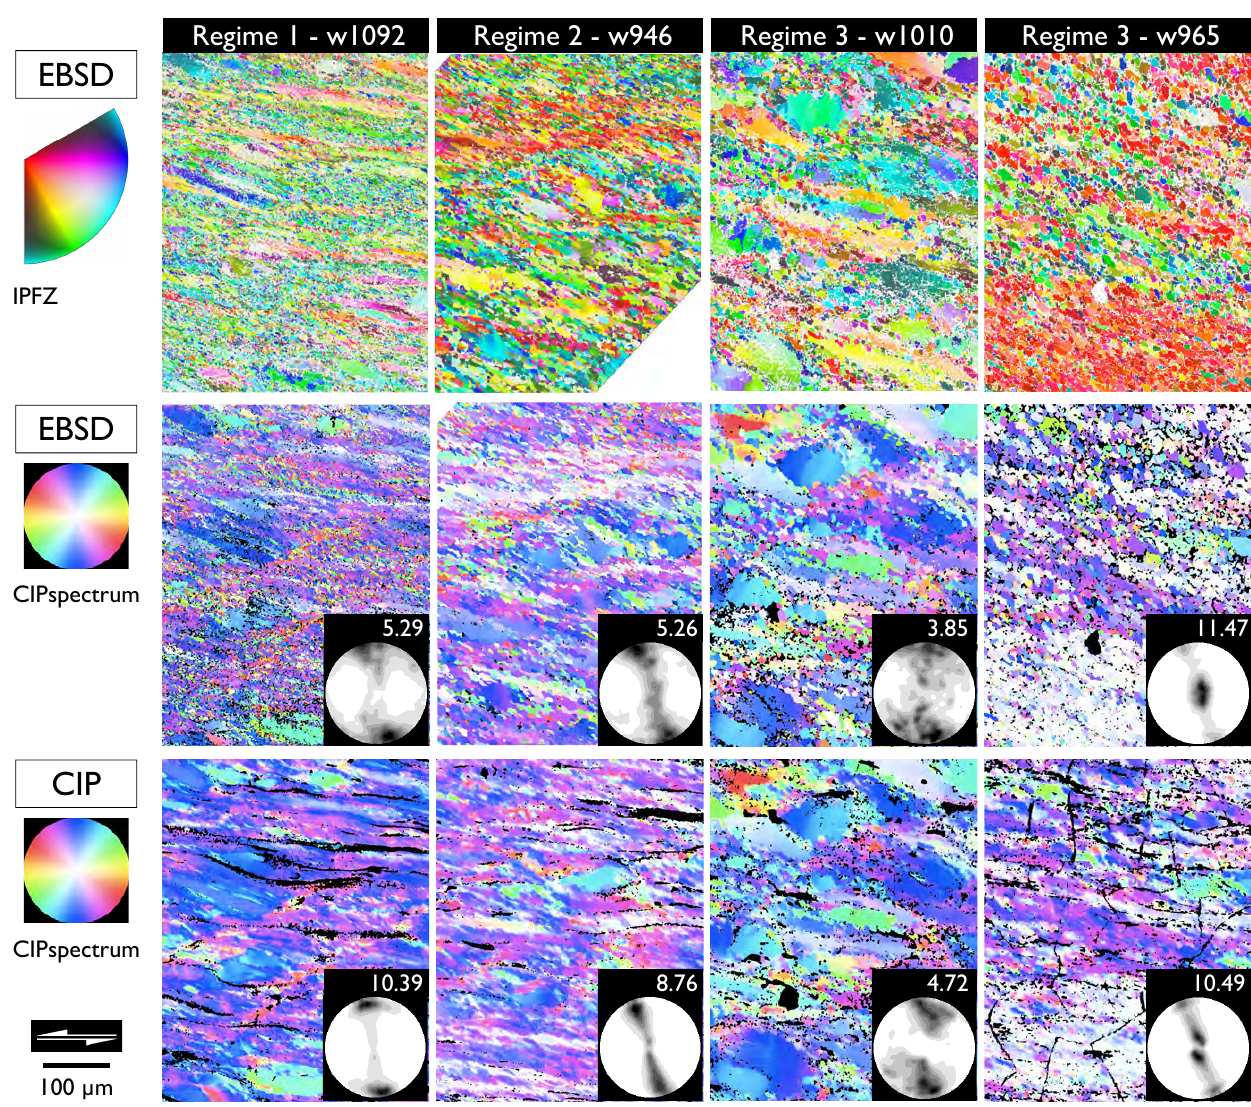
Figure 2. Orientation images. Details of four orientation images are shown with pole figures calculated from total maps. Top row: EBSD maps obtained from SEM using IPFZ (inverse pole figure coloring) for the z direction (image normal). Middle row: Same maps as in row above using CIPspectrum, i.e., LUT for c -axis orientation; c -axis pole figures calculated from EBSD-derived ODF with maximum indicated above. Bottom row: CIP maps (obtained by polarization microscopy) using same CIPspectrum, i.e., LUT for c -axis orientation as row above; c -axis pole figures calculated from CIP-derived azimuth and inclination images with maximum indicated above. Scale bar and sinistral shear sense apply to